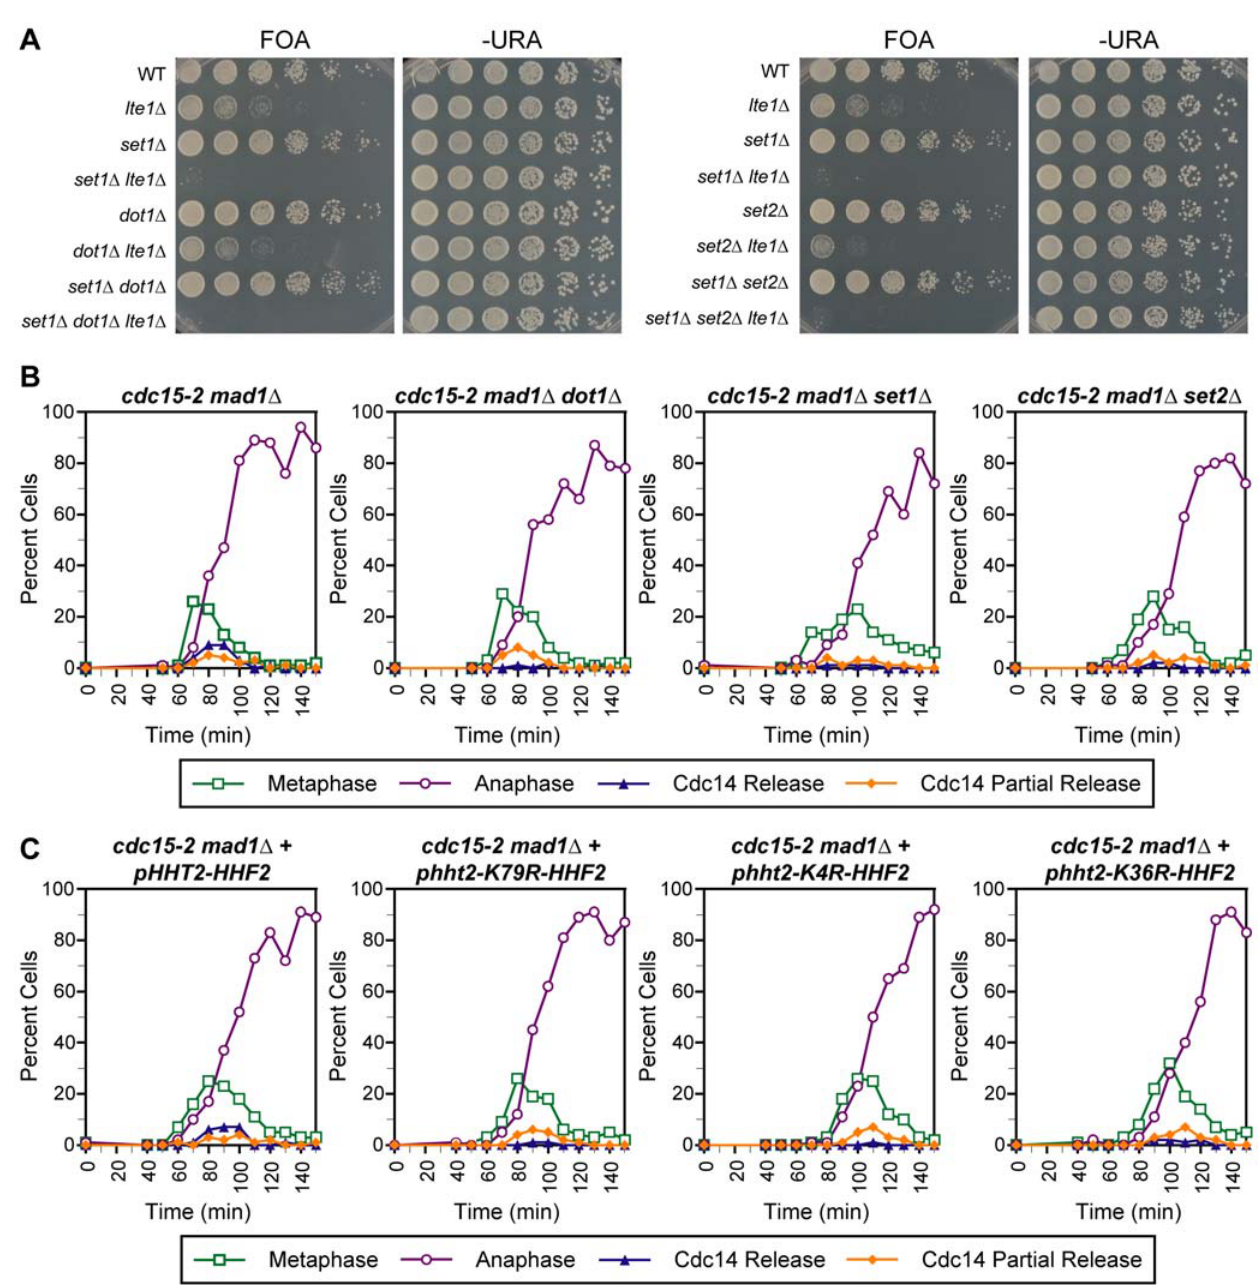
Figure 4. Genetic interaction and Cdc14 release profile of histone H3 methylase mutants combined with MEN mutants. (A) Genetic interactions of set1 D , dot1 D , set2 D , set1 D dot1 D , and set1 D set2 D mutations with the lte1 D mutation. Strains were assayed as in Figure 2A. (B,C) The temporal profile of Cdc14 release from nucleolar sequestration is displayed for strains of the indicated genotypes. Time courses were performed as described in Figure 2C.